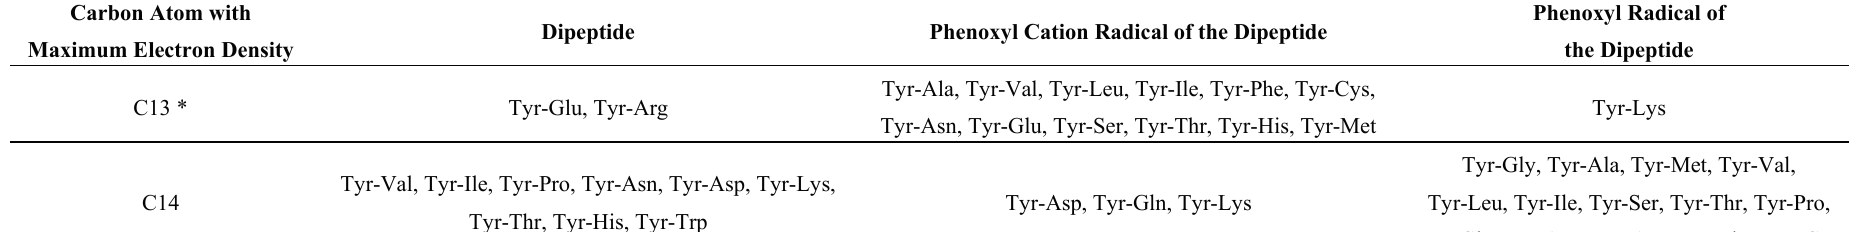
Table 8. Carbon atoms with maximum electron density in N-terminal tyrosine dipeptides and the corresponding radicals and cation radicals. Carbon Atom with